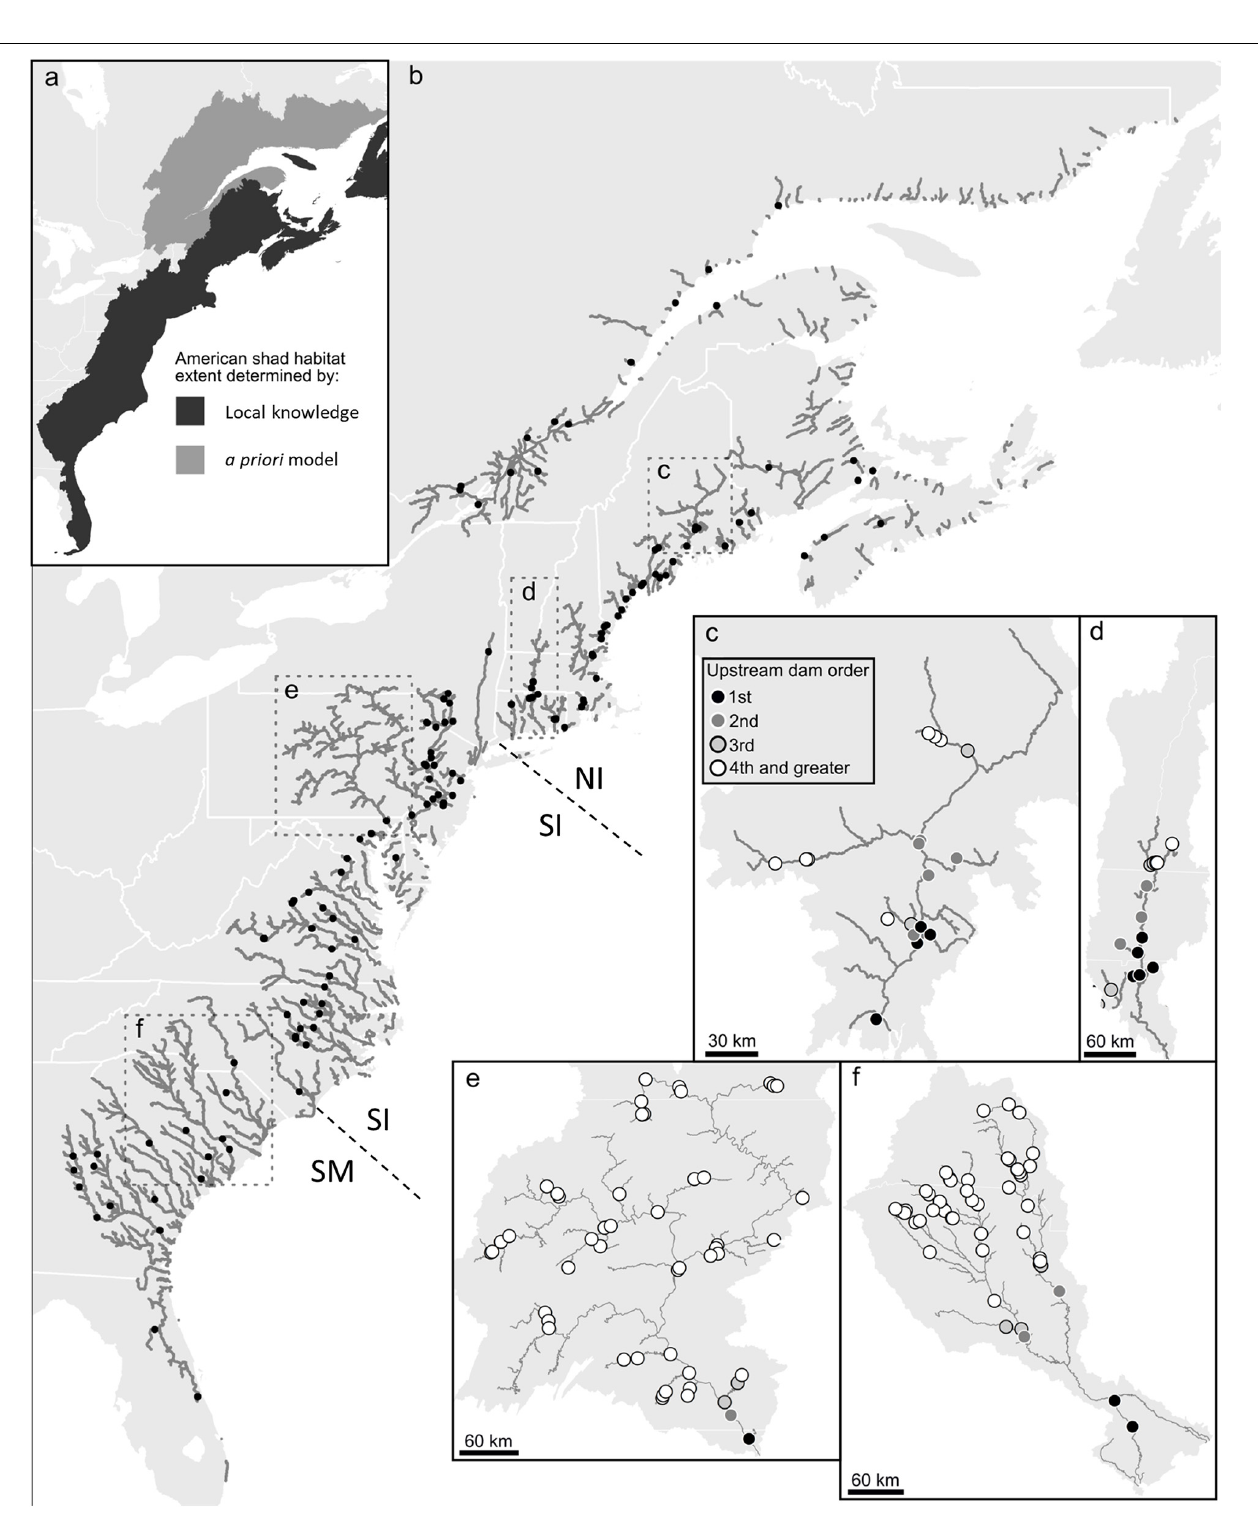
FIGURE 1 | Estimated American shad habitat through a combination of local knowledge and a priori modeling along the eastern coast of North America (a) , the full extent of their historic range. In the full panel (b) , gray lines indicate suitable riverine habitat. Only the first dam on each river or tributary is shown (black circles) for clarity. Dashed lines indicate divisions between northern iteroparous (NI), southern iteroparous (SI) and semelparous SM) eco-regions Insets provide greater detail for four rivers; Penobscot River (c) , Connecticut River (d) , Susquehanna River (e) , Cooper River and (f) the Santee River, indicating the numerous impoundments that constrain the migration of American shad in these